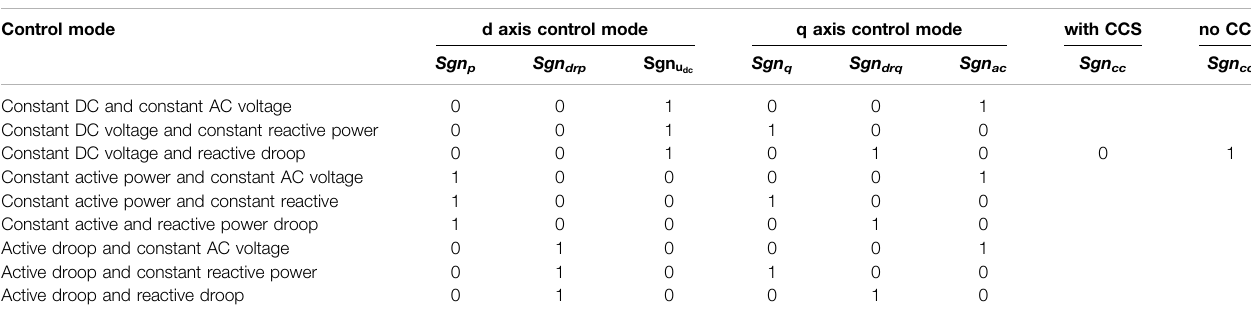
TABLE 2 | Con fi guration of control